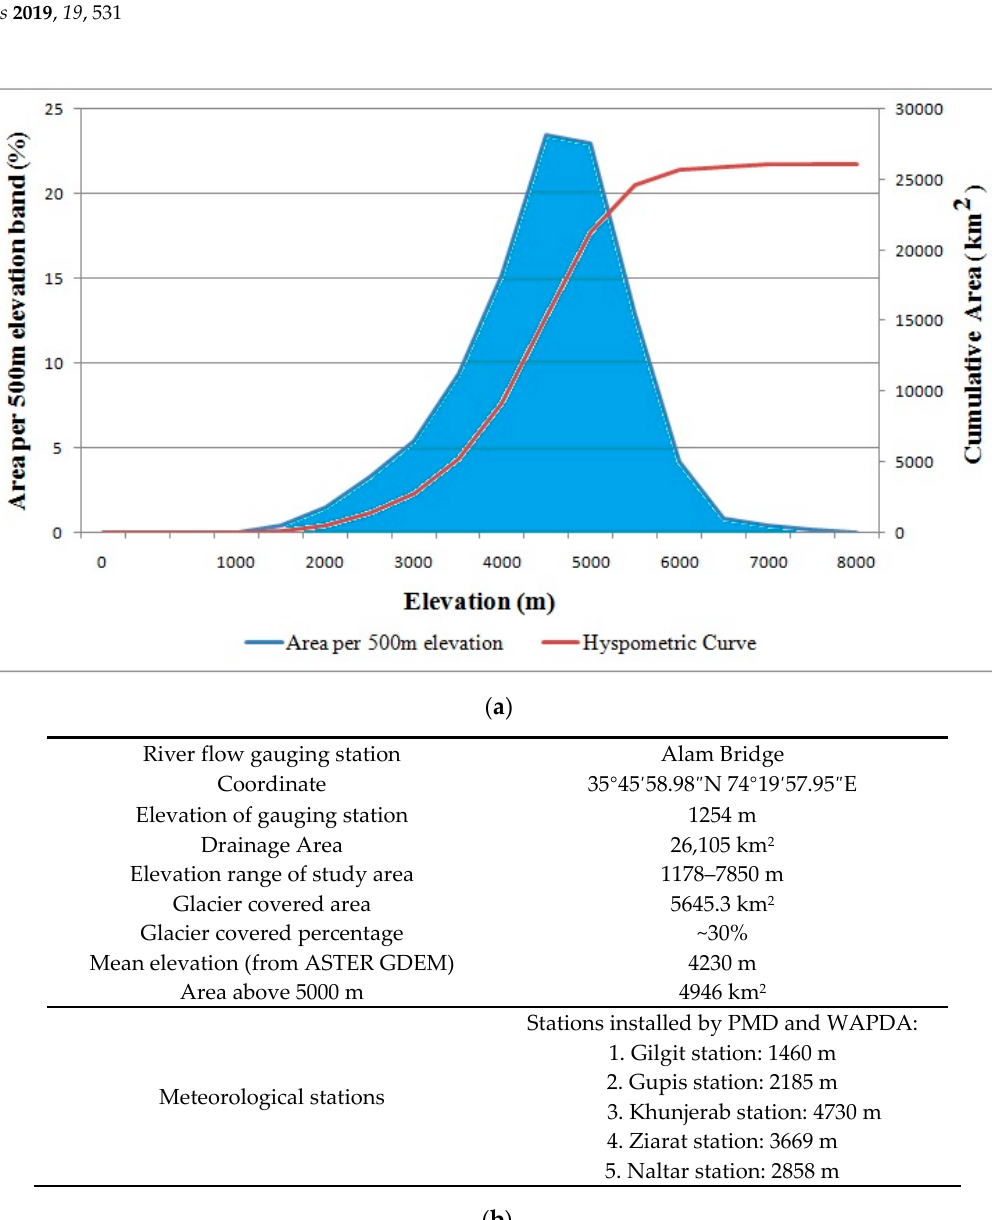
Figure 2. ( a ) Hypsometric curve of Gilgit River basin and distribution of the area by elevation. ( b ) Gilgit Basin key characteristics.